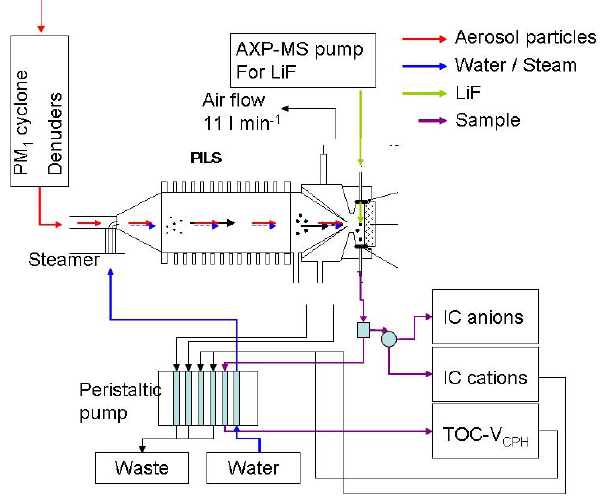
Fig. 1. PILS-TOC-IC measurement device. Arrows represent the flow of the sample and liquids within the